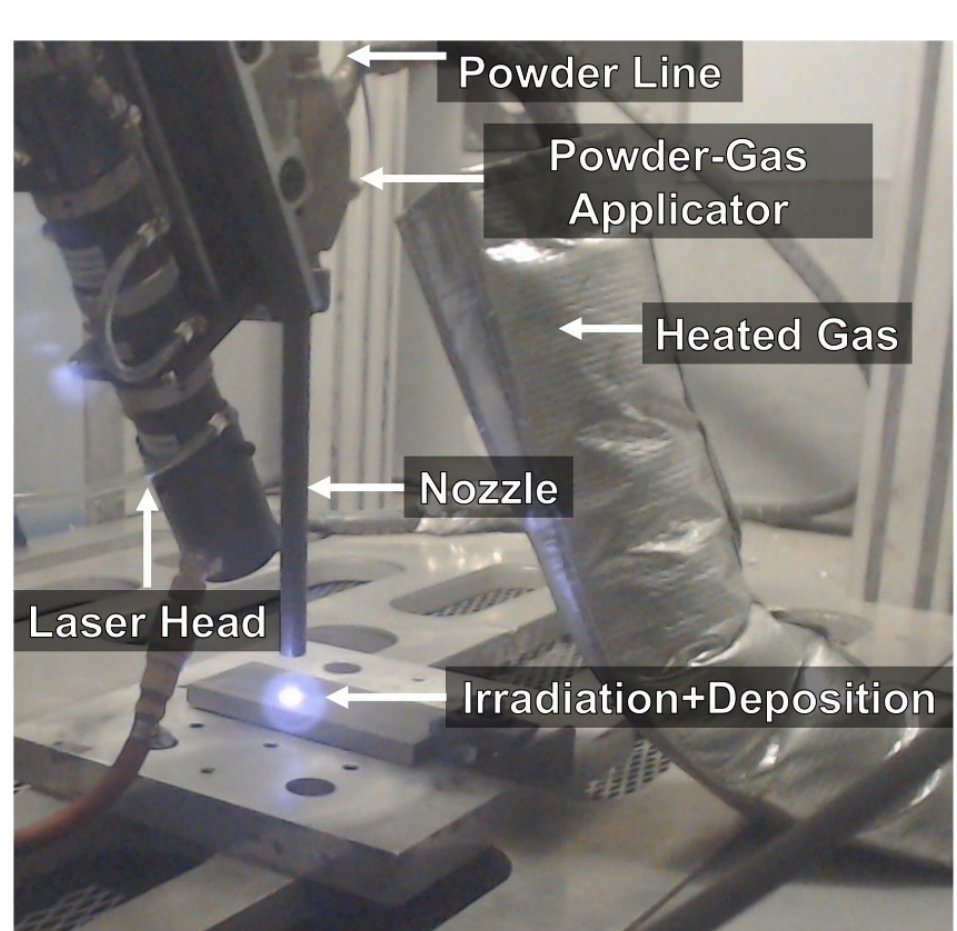
Figure 17. Overview of the LACS process. Reprinted with permission from [190]. Copyright 2020 Elsevier.